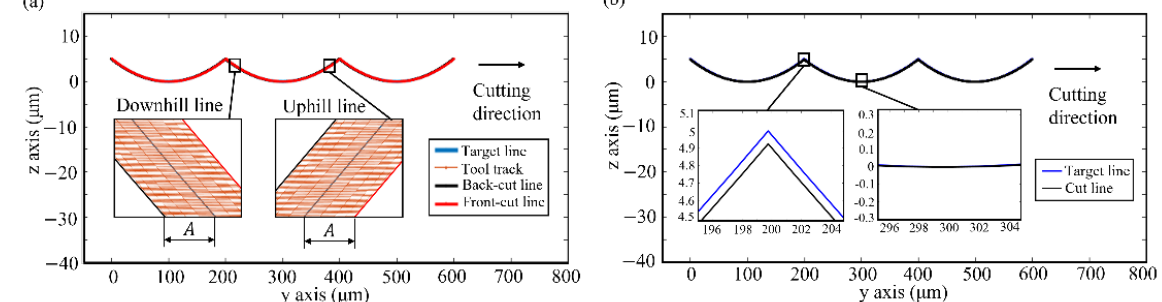
Figure 2. ( a ) Tool trajectory in HFUVAS of the target line of microlens array, ( b ) a comparison of the target line and cut line, with r of 1 mm and p 2 of 199.75 µm.